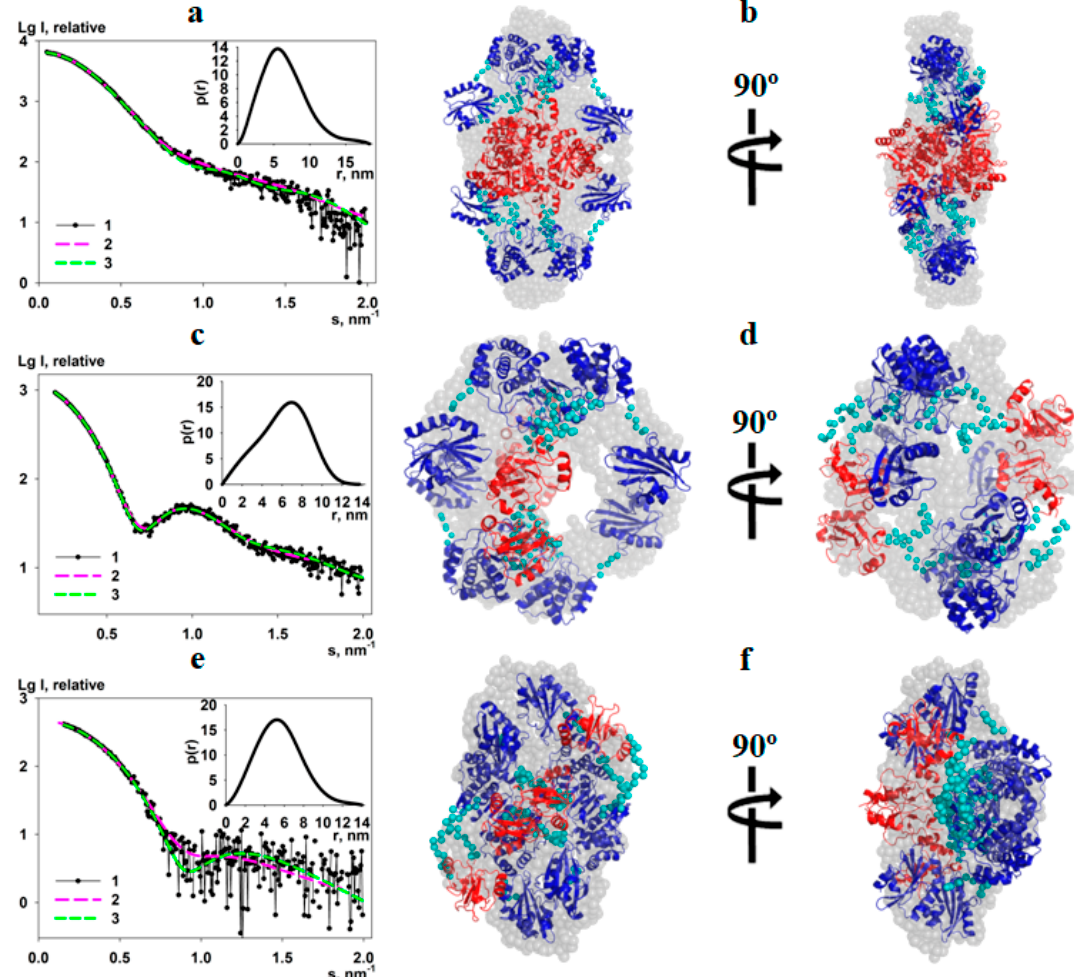
Figure 2. Scattering data from the full-length CBS-PPases and their shape restoration by ab initio and hybrid modeling methods. Panels ( a , c , e ) display the experimental SAXS data (1) and the fits from GASBOR (2) and CORAL (3) models; the distance distribution functions p(r) are displayed in the insets. Panels ( b , d , f ) present the comparison of ab initio GASBOR models (grey semitransparent spheres) and hybrid CORAL models (ribbons). From top to bottom: dh-PPase, eh-PPase, and